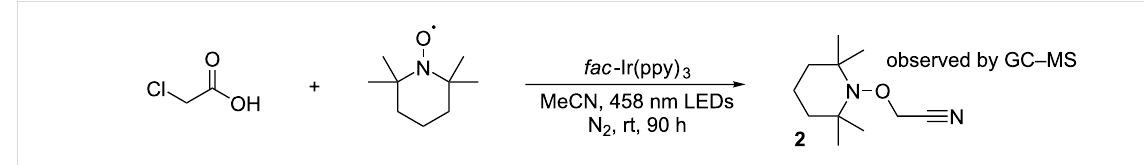
Table 1: Conditions screening for the photoredox catalyzed reaction between monochloroacetic acid and styrene. a